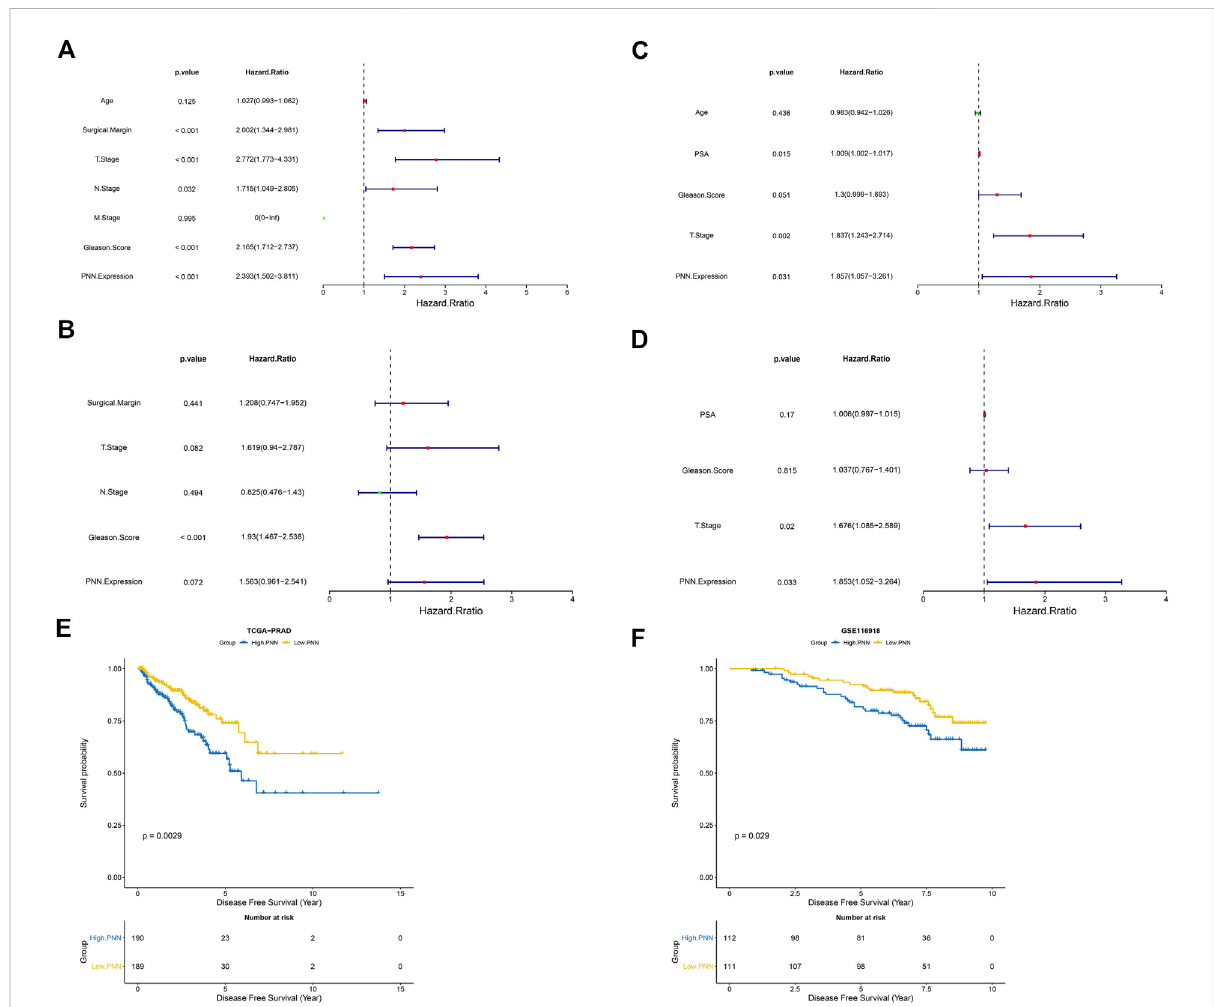
FIGURE 4 PNN prognosticvalueintheTCGA-PRAD andtheGSE116918 cohorts. Forest plotsofunivariateandmultivariate Coxregressionanalysisforthe TCGA cohort (A) univariate, (B) multivariate and the GSE116918 cohort (C) univariate, (D) multivariate. (E,F) DFS curves plotted according to the KM method for the TCGA-PRAD and GSE116918 cohorts using the log-rank